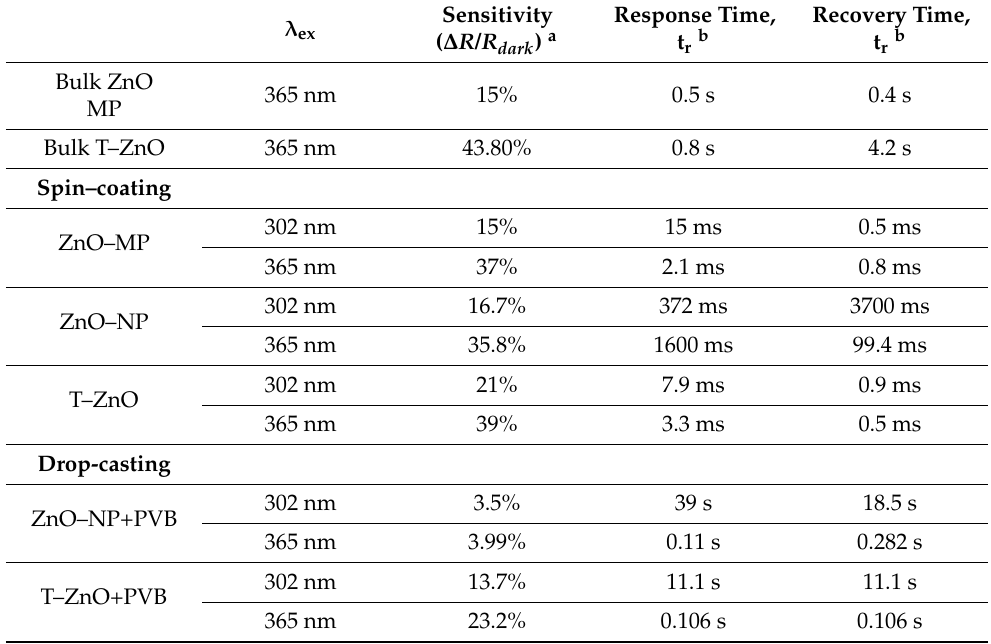
Table 1. Summary of sensitivity, response time, and recovery time for various ZnO morphologies and microstructures tested in this